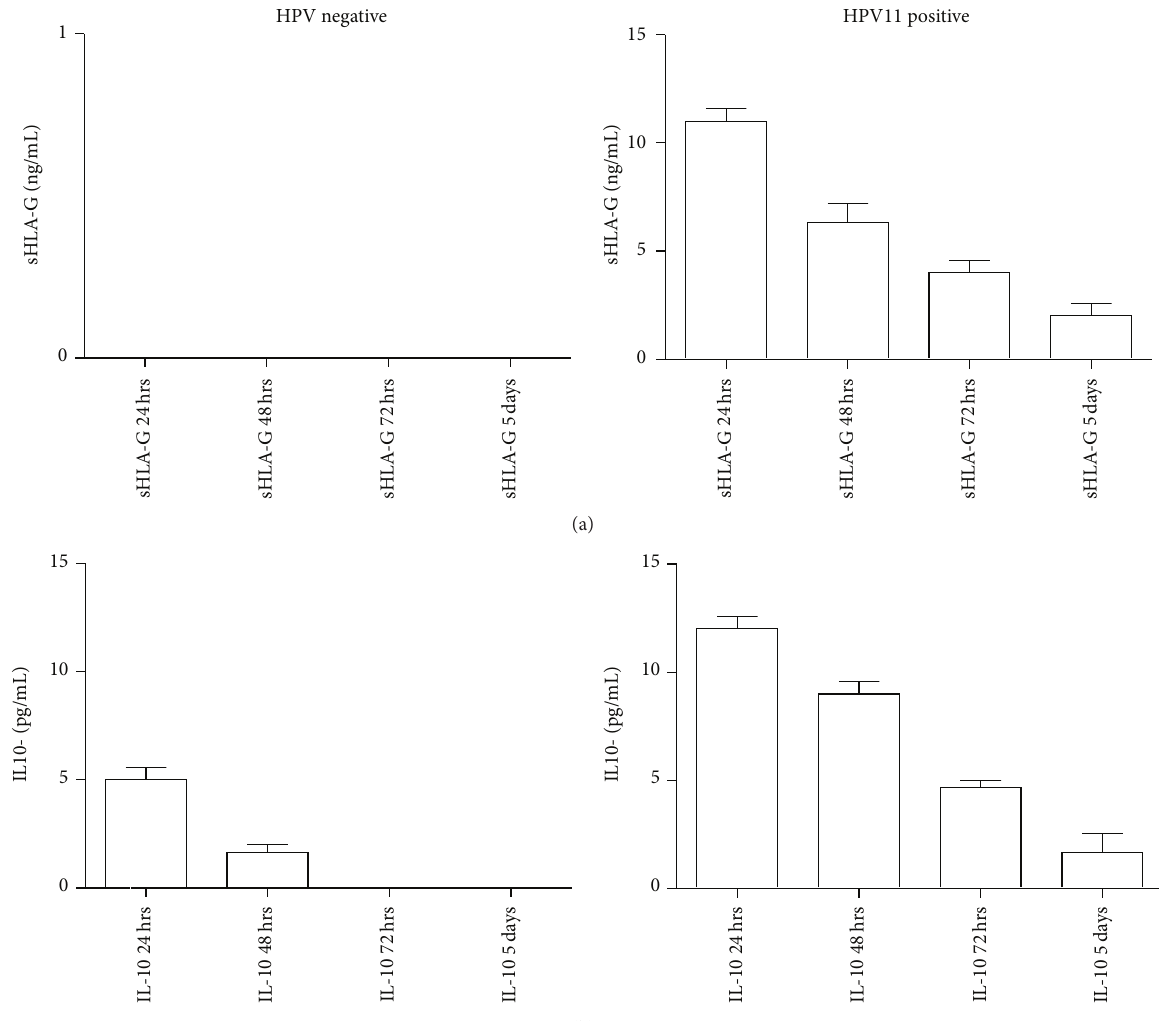
Figure 3: (a) sHLA-G and (b) IL-10 levels in epithelial cell culture supernatants from HPV negative and HPV-11 positive SNP-WoAD patients during a 5-day in vitro